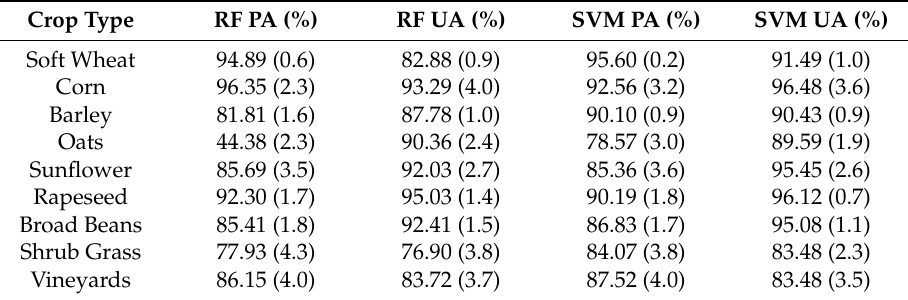
Table 4. Producer’s accuracy and user’s accuracy for both Random Forest (RF) and Support Vector Machine (SVM) classifications for the crop type nomenclature level. The standard deviation of the mean accuracy values is also shown in parentheses.